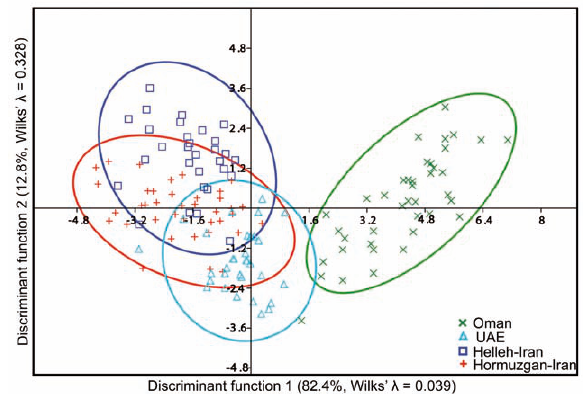
Fig . 4. – Discriminant function scores with 95% ellipses for all oto- lith variables of Aphanius dispar populations.